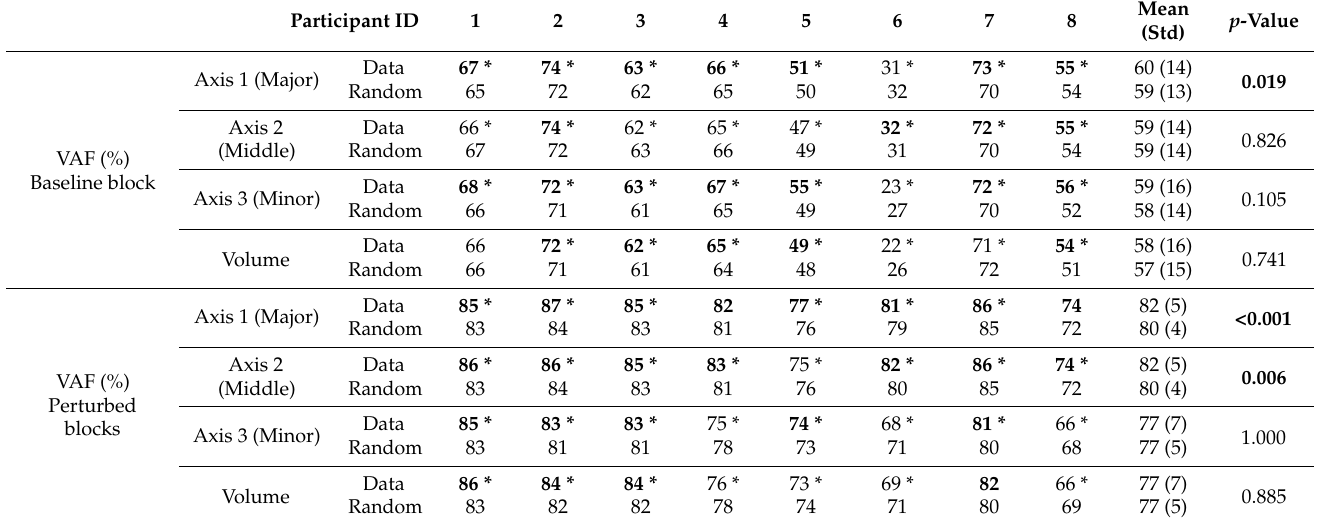
Table 2. VAF calculated with the axes and the volume of the stiffness ellipsoid approximated by the product of the null-space projection of the muscle activation, normalized to the ratio between the mean null-space projection of the muscle activation divided by the mean value of the ellipsoid axes or volume. In the table, both the VAFs calculated by fitting of the norm of the null-space projection obtained from data ( “ Data ” ) and the 95% percentile, over 500 repetitions, of the product of the null- space projection of the muscle activation, randomly shuffled during each repetition ( “ Random ” ) are reported. VAF reported in bold identifies “ Data ” values higher than “ Random ” values. VAF values reported with an asterisk (*) indicate a significant regression ( p < 0.05) of the variable with the norm of the null-space projection of the muscle activation. The penultimate column reports the mean (std) values across participants. The last column reports the p -values of Student ’s t -test between the VAF values reported in “ Data ” with respect to those reported in “ Random ” . Values reported in bold indicate a significant difference ( p < 0.05).